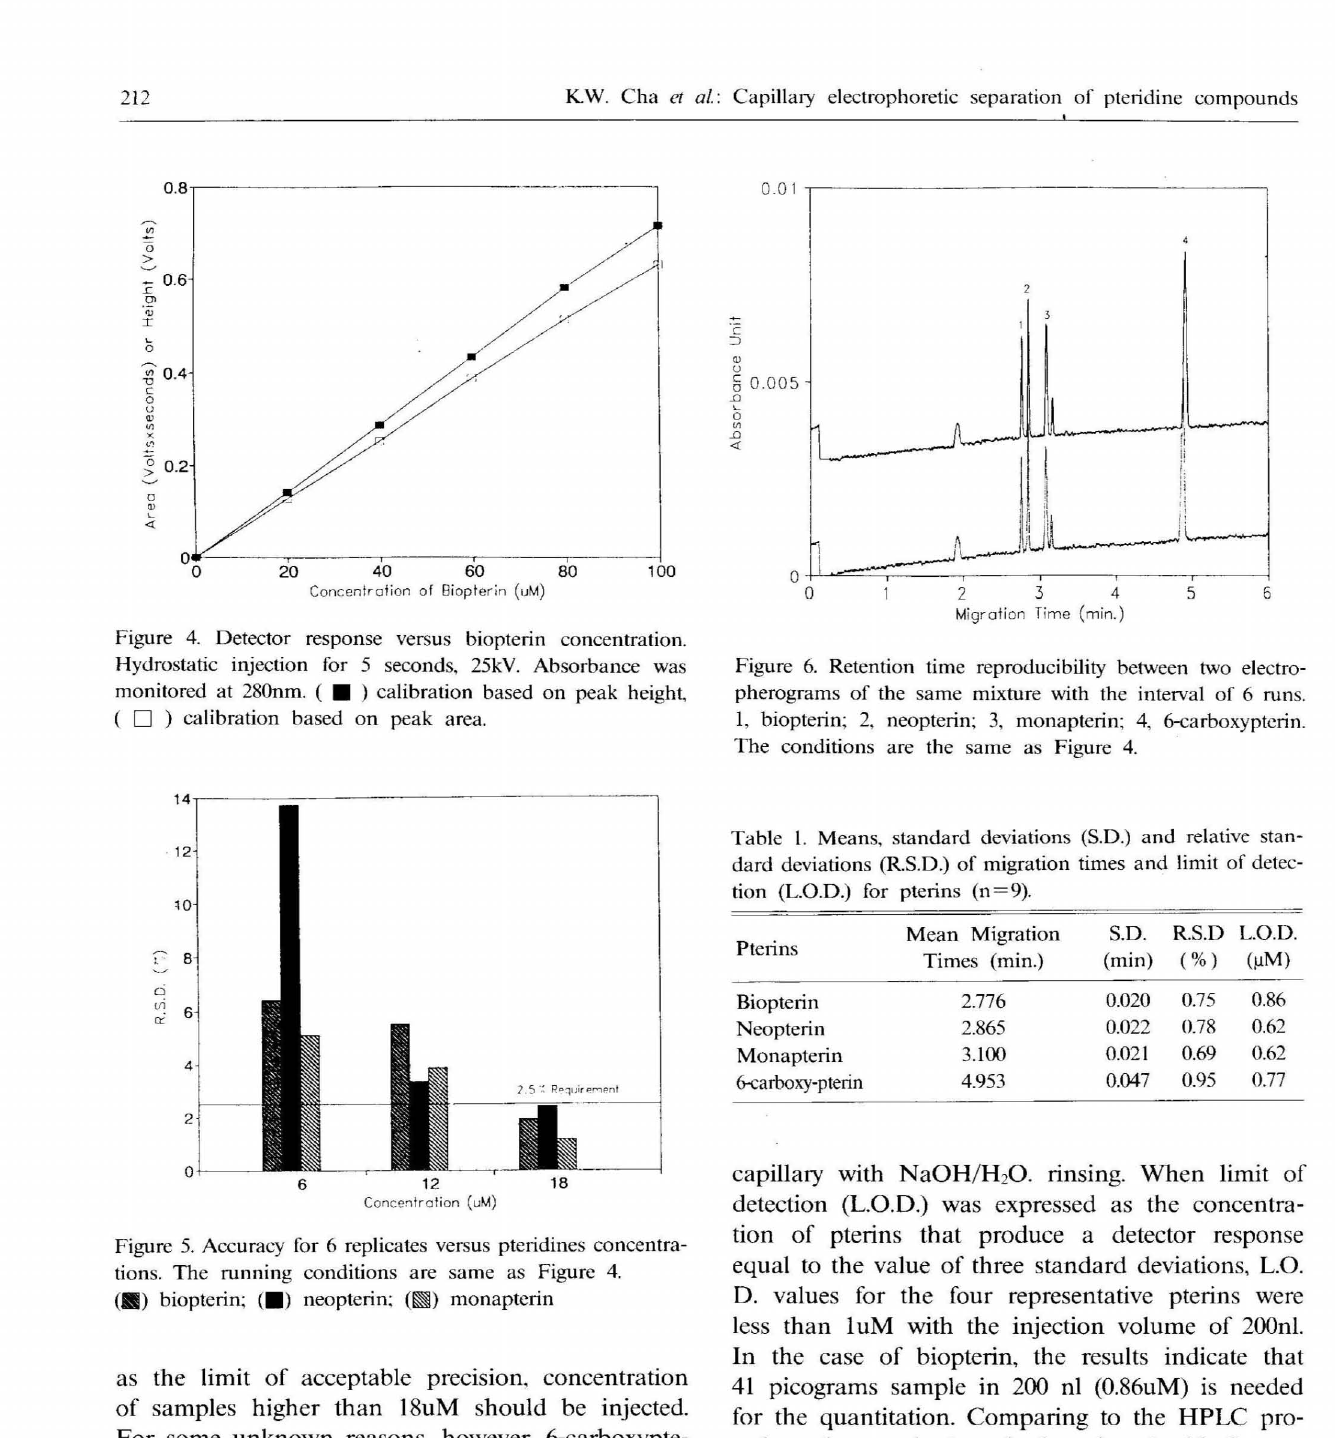
Figure 5. Accuracy for 6 replicates versus pteridines concentra tions. The running conditions are same as Figure 4. (III) biopterin; C.) neopterin; (~) monapterin